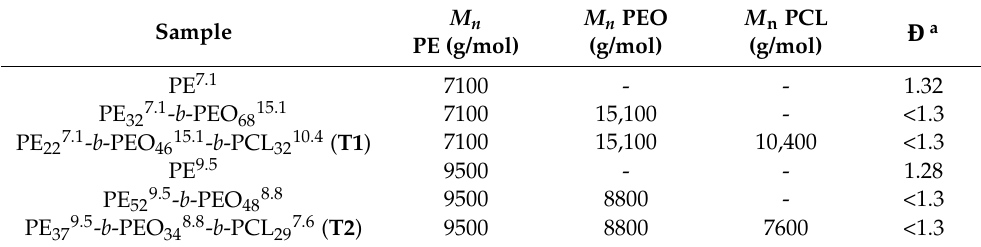
Scheme 1. Synthesis of tricrystalline terpolymer PE- b -PEO- b -PCL by a combination of polyhomolo- gation and two catalyst-switch strategies [102]. Table 1. Number-average molecular weight ( M n ) and polydispersity of homopolymers, diblock copolymers, and triblock terpolymers. Subscripts represent composition in wt %, and superscripts indicate M n values of each block in kg/mol.